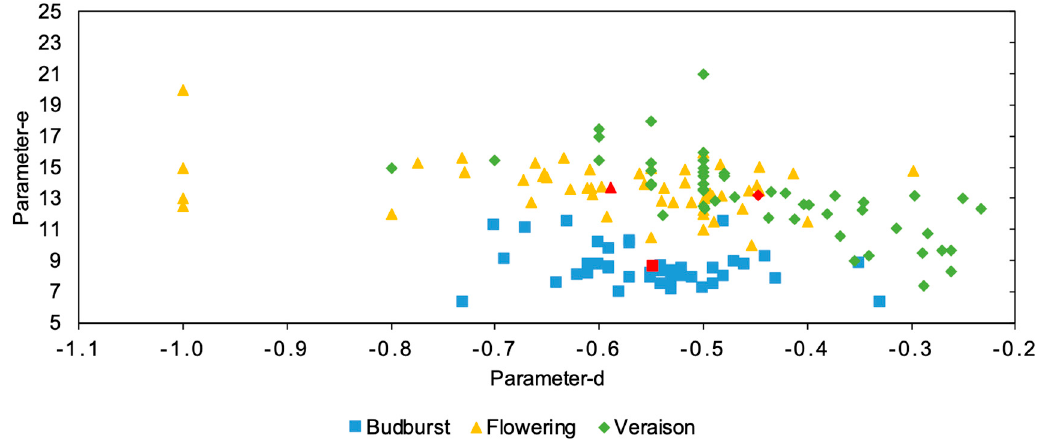
Figure 4. Scatterplot of the sigmoid model (SM) parameters d and e and the corresponding centroids 328 for the three phenological stages (budburst, flowering, and veraison) in red. 329